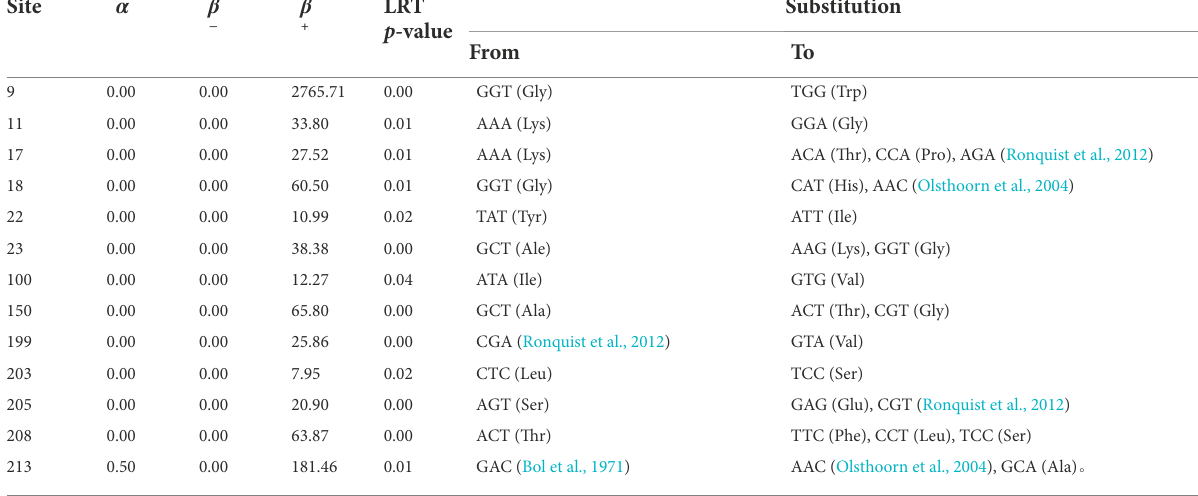
TABLE 3 Sites under episodic selection detected by the